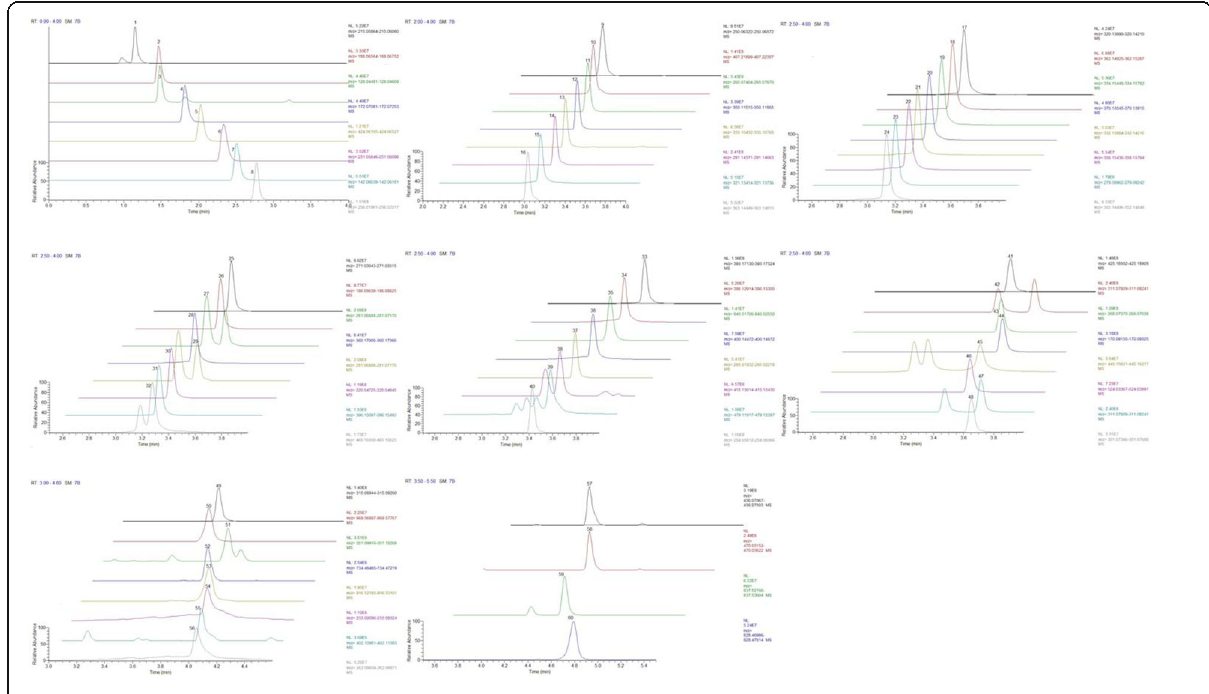
Fig. 1 Separation of 60 veterinary antibiotic residues in Thermo Hypersil GOLD